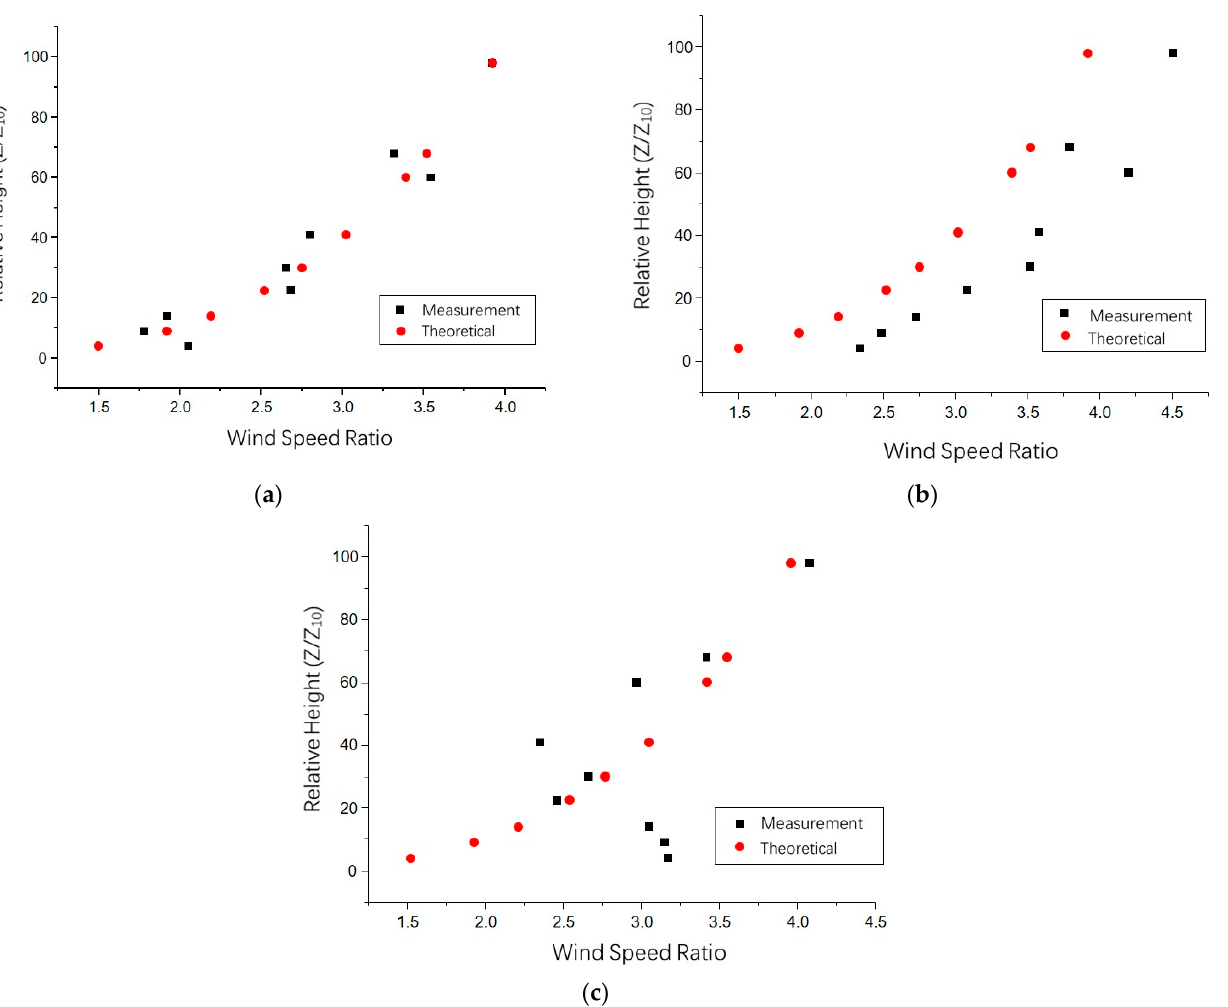
Figure 10. Average wind speed of the different sections behind the grid plate (5000 m 3 /h, 50 Hz). ( a ) 0.2 m away from the grid plate; ( b ) 0.5 m away from the grid plate; ( c ) 1.5 m away from the grid plate.